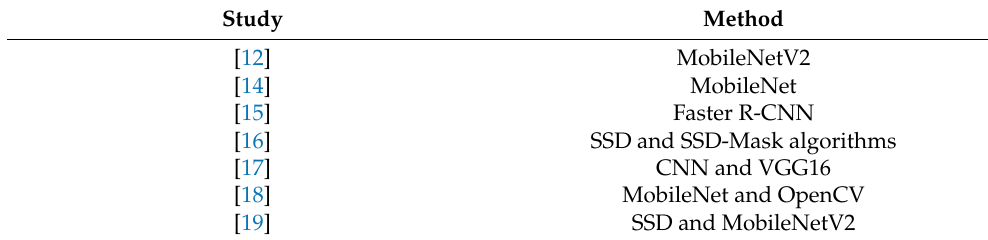
Table 1. A summary of recent facemask detection